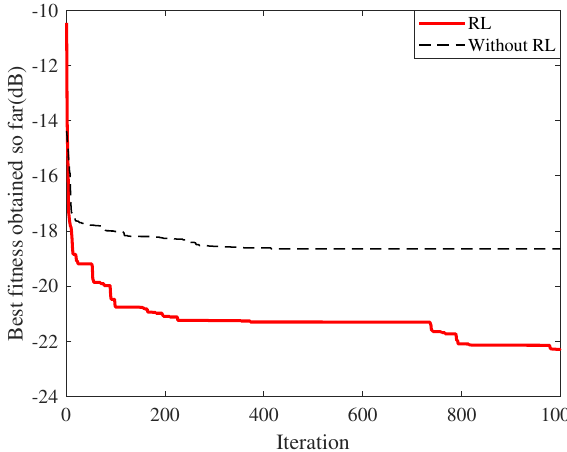
Figure 10. The iterative process with and without